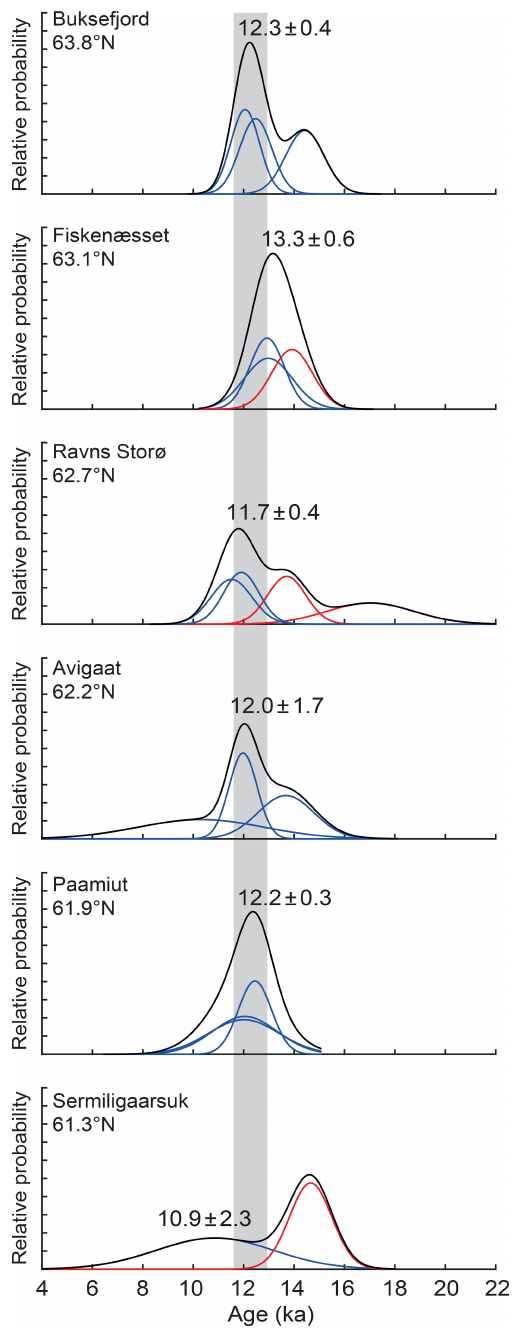
Figure 3. Normal kernel density plots for the 10Be ages from six coastal sites in SW Greenland. The mean age (black) is calculated based on the individual samples (blue) after excluding statistical outliers (red) (see Table